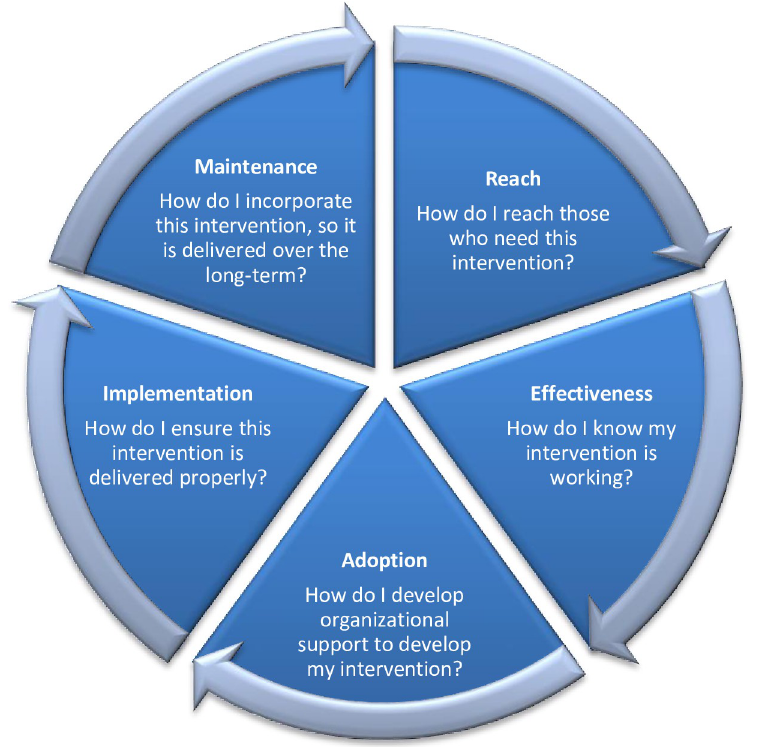
Fig 1. Schematic figure depicting the RE-AIM